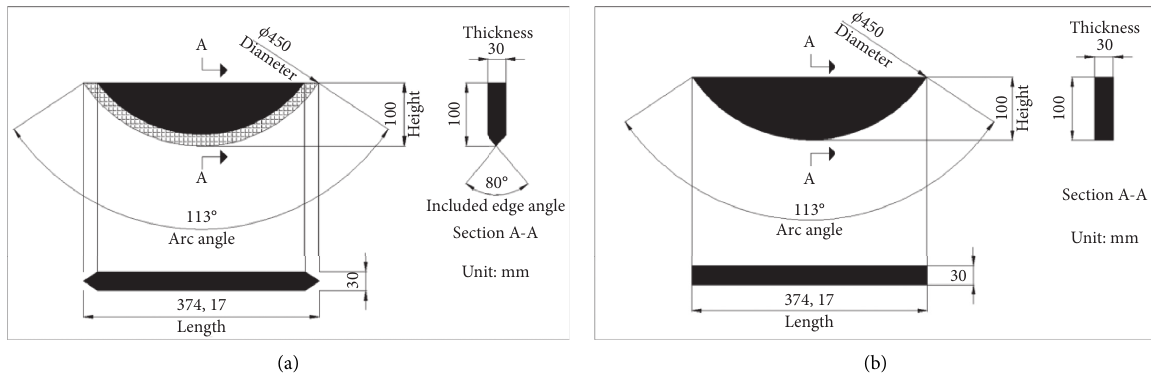
Figure 2: Fabricating drawings of the designed cutters: the V shape one (a) and CCS one (b).